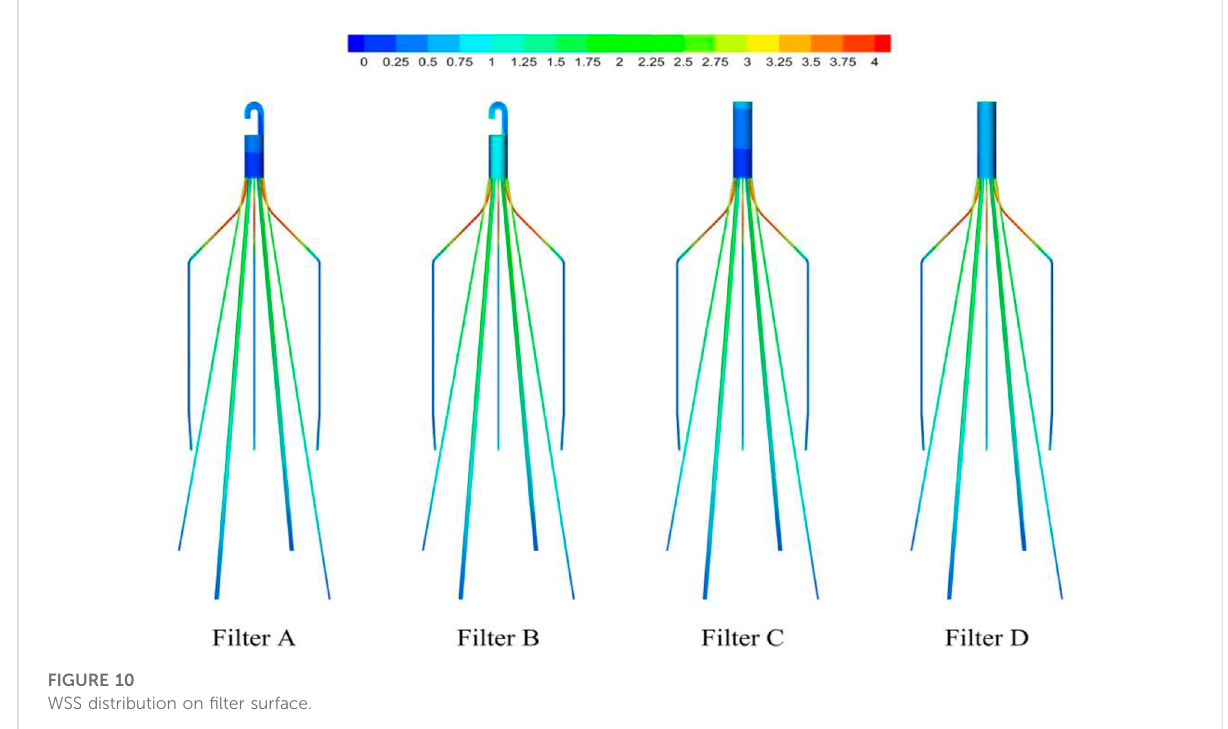
FIGURE 10 WSS distribution on fi lter